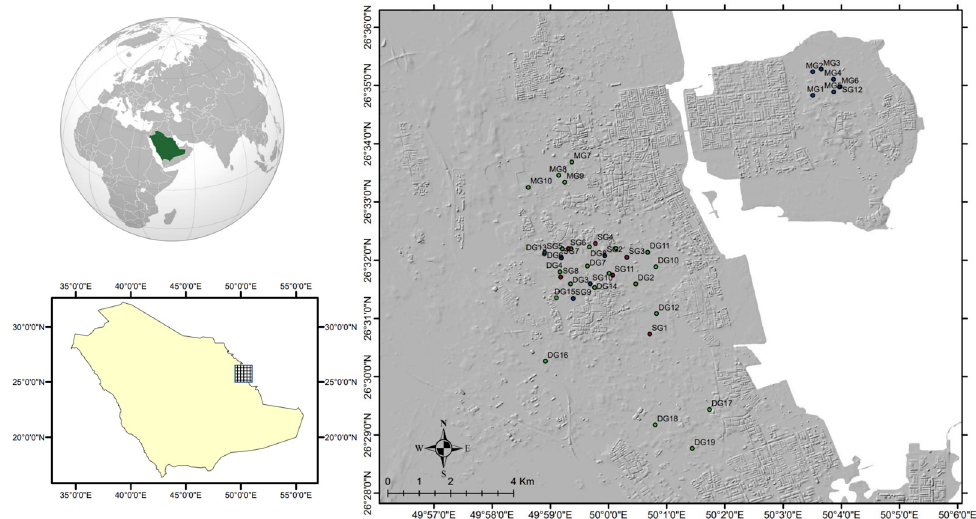
Figure 1. Map showing the location of the study area and GW samples.